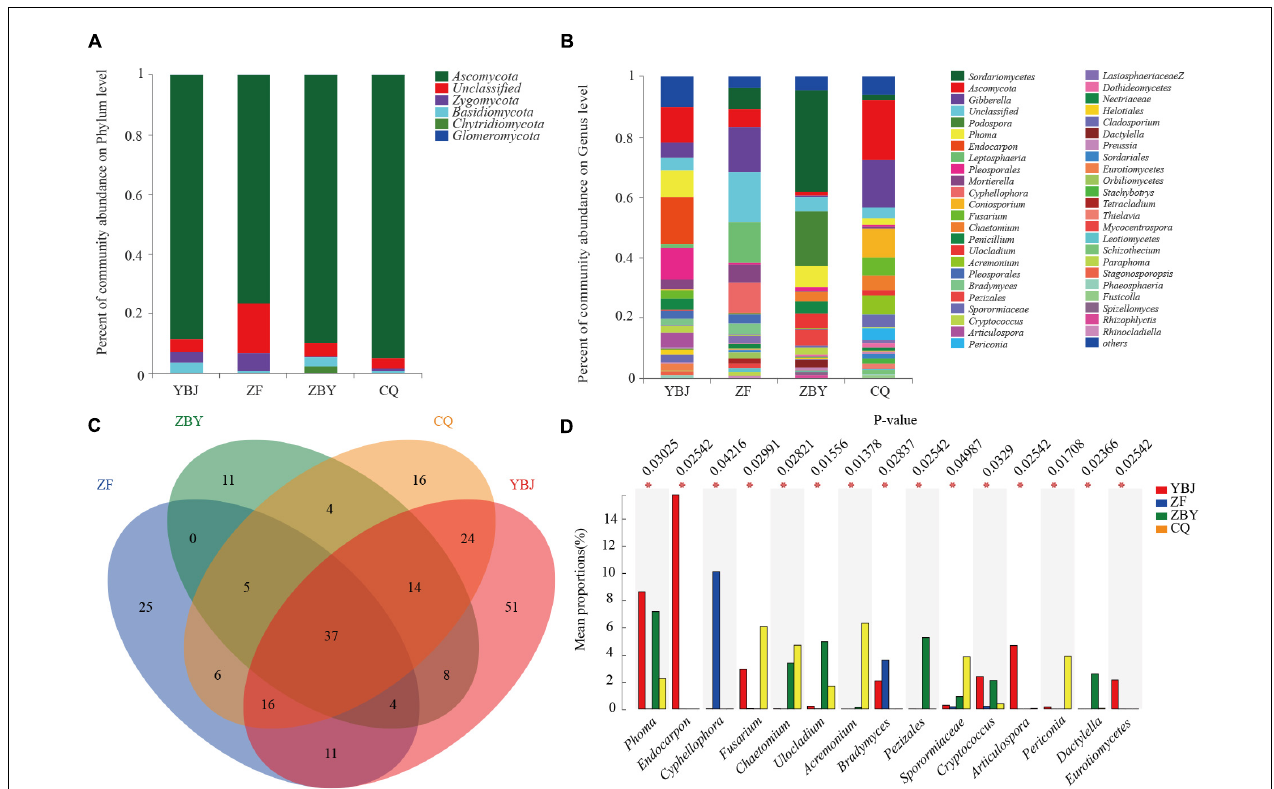
FIGURE 2 | Root system soil fungal community structure at the genus and phylum levels and a Venn diagram based on the genus level. (A,B) Fungal community structure based on the phylum and genus levels. (C) Venn diagram based on the genus level. (D) Analysis of differences between groups of fungal communities ( ∗ 0.01 < P ≤